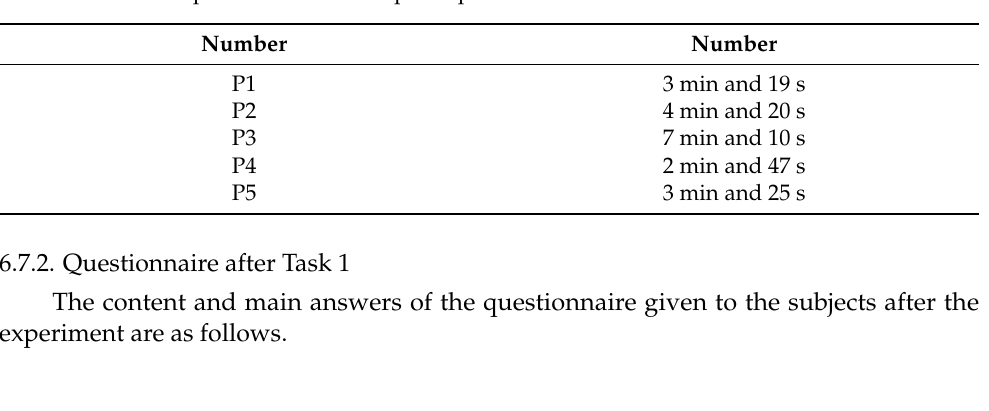
Table 1. Task 1 completion time of each